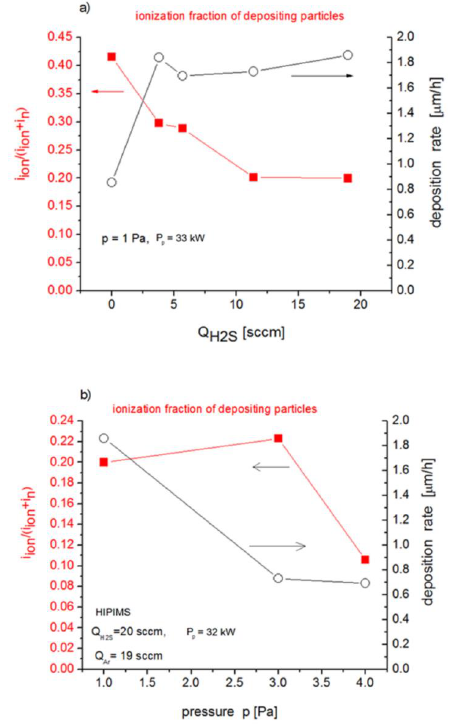
Figure 4. ( a ) Dependence of ionization fraction of depositing particles r = i ion / (i ion + i n ) (left axis) and deposition rate (right axis) on the mass flow rate of H 2 S Q H2S . ( b ) Dependence of ionization fraction of depositing particles r = i ion / (i ion + i n ) (left axis) and deposition rate (right axis) on the gas pressure in the reactor, p. Coatings 2020 , 10 , 246